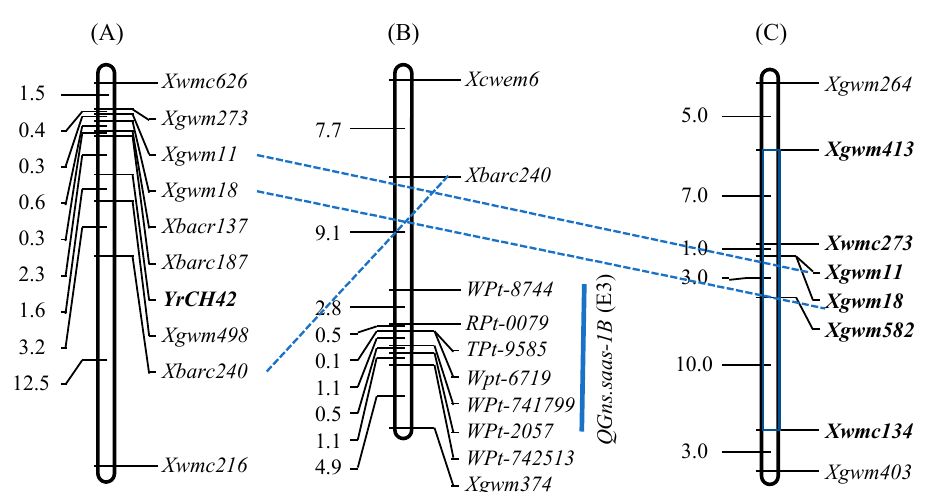
Figure 4. Molecular mapping of ( A ) YrCH42 , ( B ) QTL for grain number per spike (GNS), and ( C ) the SHW alleles introgressed to Chuanmai 42 on chromosome 1B. Note: the interval in gray and the loci in bold italics were from Syn769.